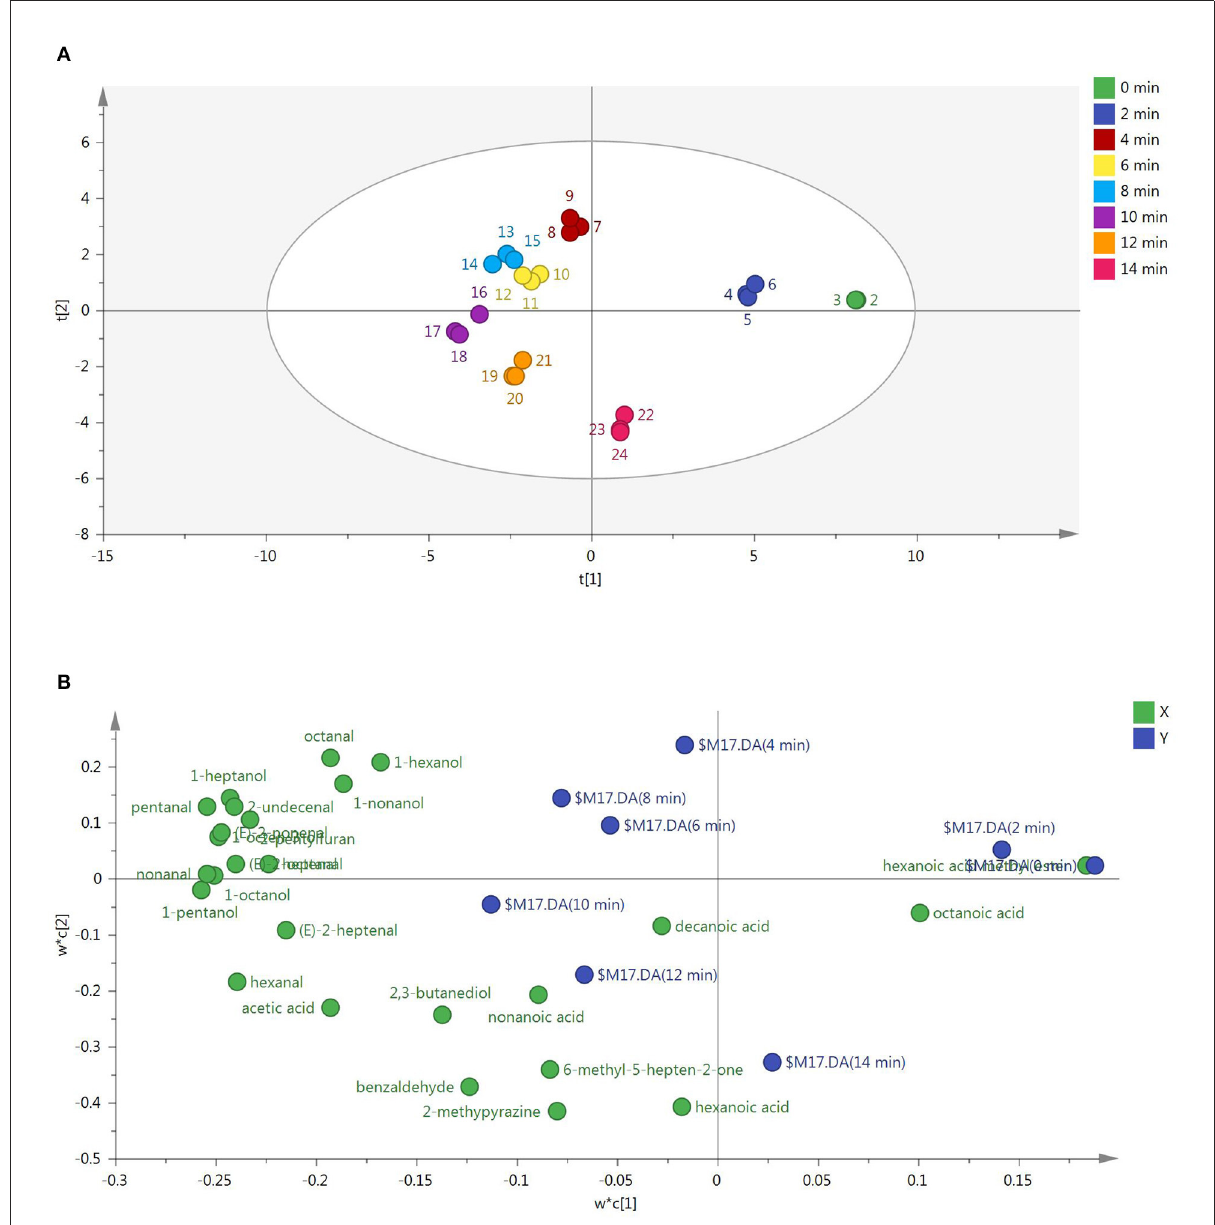
FIGURE1 (A) PLS-DA of roasted mutton during the roasting process based on aroma compounds. Samples at each roasting time were measured for 3 replicates. (B) PLS-DA of aroma compounds in roasted mutton during the roasting process. X and Y in the top right represented roasted mutton with different roasting time and aroma compounds